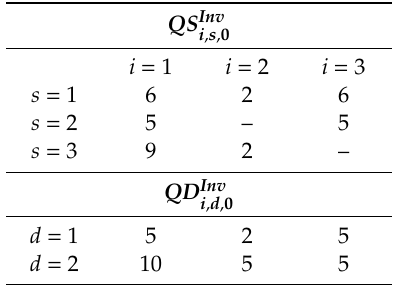
Table A25. Initial inventory level (units).